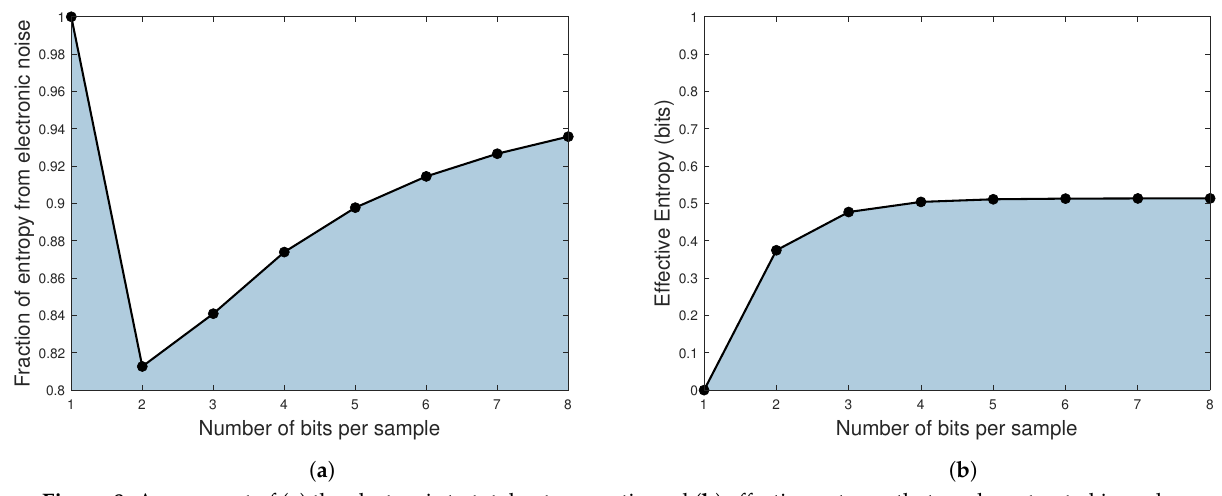
Figure 8. Assessment of ( a ) the electronic to total entropy ratio and ( b ) effective entropy that can be extracted in each sample for multiple sequence